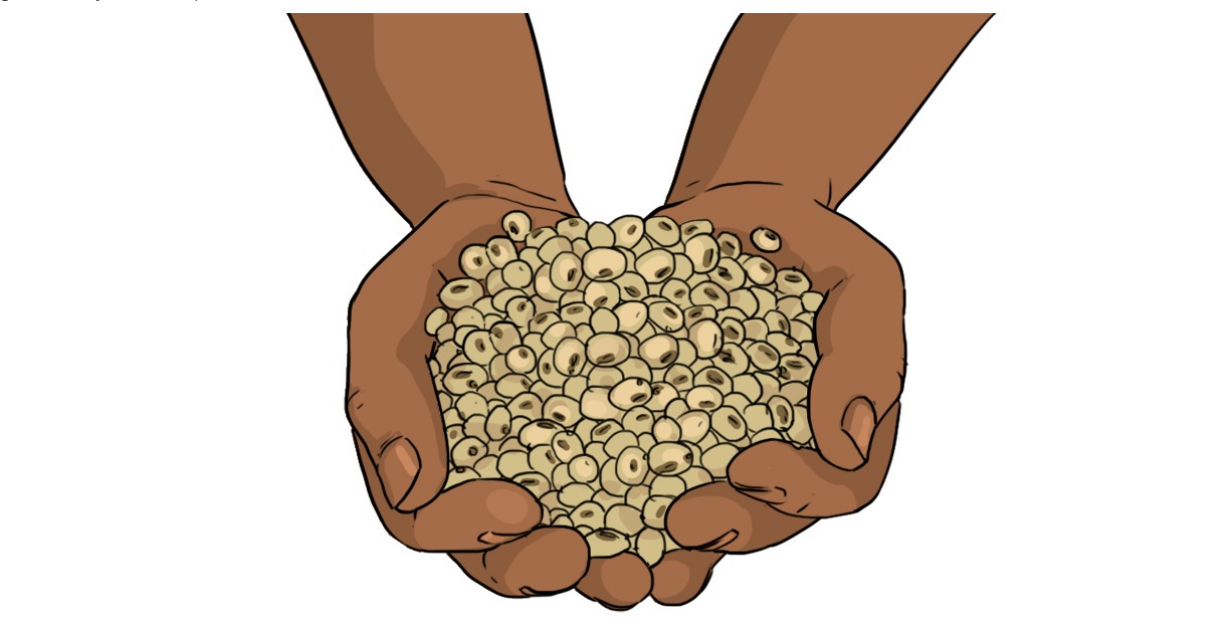
Figure 7. Soya after